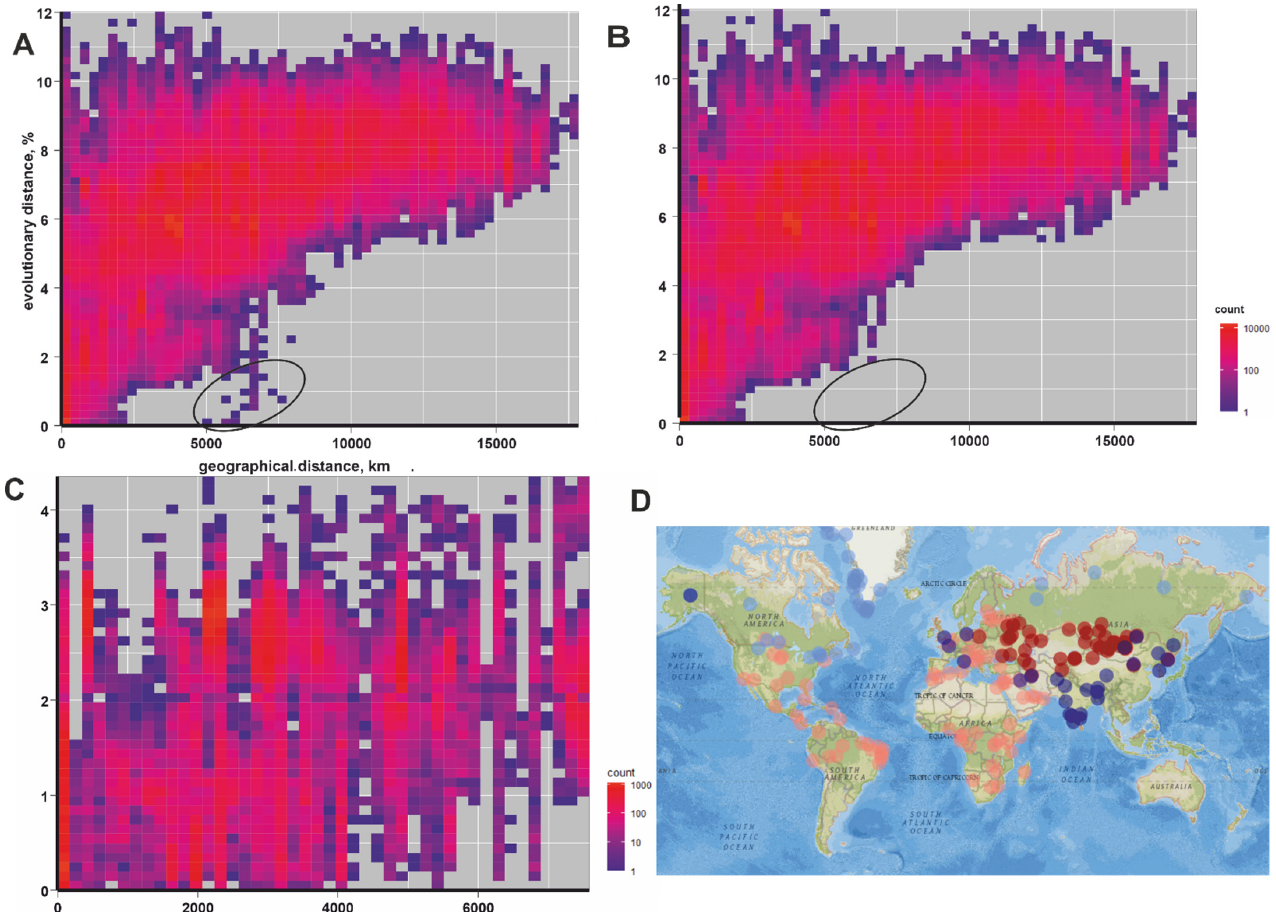
Figure 2. ( A ) Gene-geo plot for cosmopolitan RABV group ( n = 1824). ( B ) Gene-geo plot for cosmopolitan RABV group without two sequences of viruses transferred between distant regions (#KP997032, #KC737850). ( C ) Gene-geo plot for the Arctic RABV group ( n = 453). ( D ) The distribution of the cosmopolitan group (pale red), the steppe subgroup of cosmopolitan group (dark red), the Arctic-like group (dark blue), and the Arctic group (pale blue) in the global map. The interactive map with labeled markers is available at https://rpubs.com/andreideviatkin/RABVdistribution (assessed on 28 December